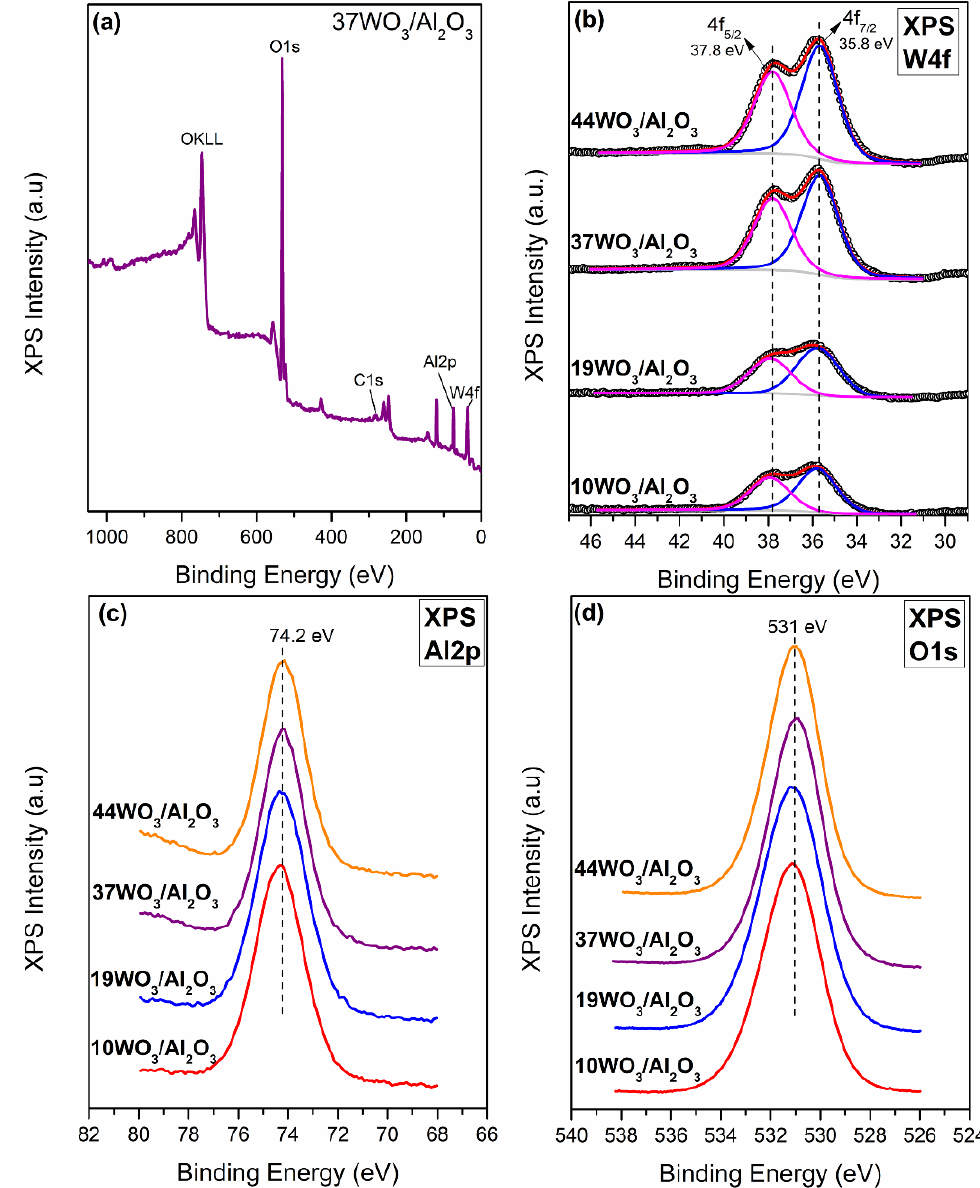
Figure 4. ( a ) Survey spectra of 37WO 3 /Al 2 O 3 catalyst; ( b ) W4f XP spectra; ( c ) Al2p XP spectra; ( d ) O1s spectra of WO 3 /Al 2 O 3 catalysts.